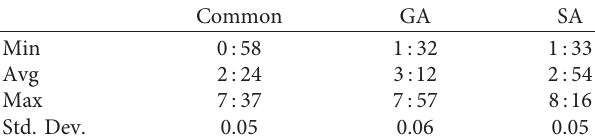
Table 2: Text entry rates (min :sec).